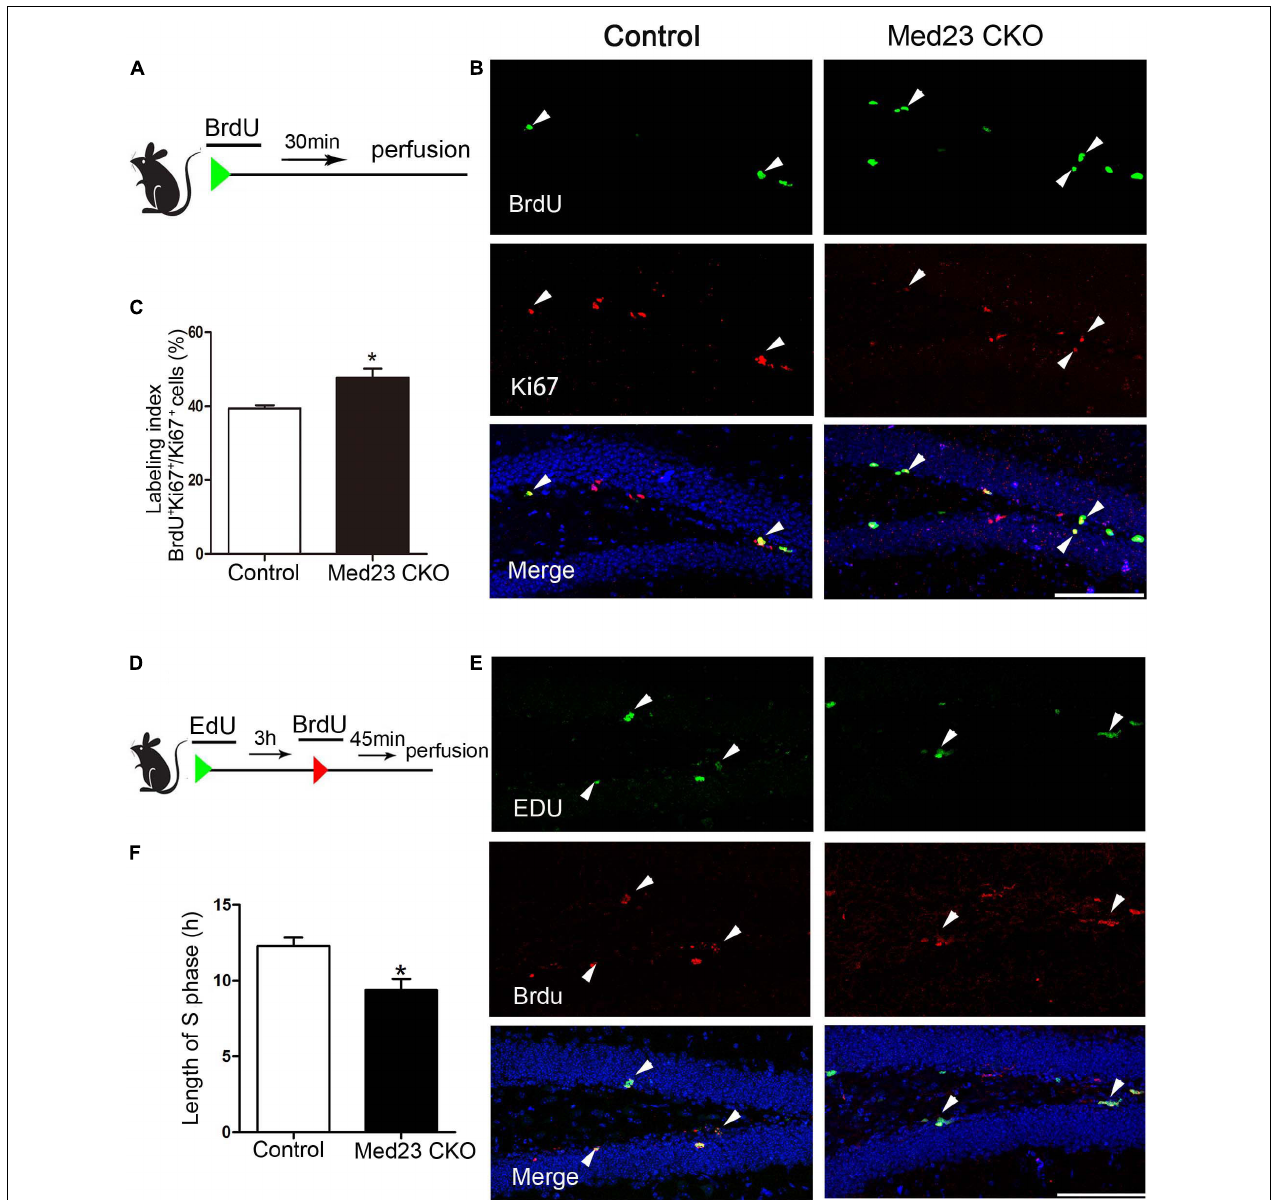
FIGURE 3 | Loss of Med23 affects cell cycle progression of NSCs in the SGZ of adult mice. (A) Schematic representation of BrdU injection. (B) Double immunostaining of BrdU (green) and Ki67 (red) in BrdU-injected mice. Triangles point to BrdU + /Ki67 + cells. Hoechst (blue) was used for counterstaining. Scale bar = 100 µ m. (C) Percentage of BrdU + /Ki67 + cells in the total of Ki67 + cells (labeling index) is significantly increased in Med23 CKO mice compared with controls. N = 5 mice in control and 4 in Med23 CKO groups. (D) Schematic representation of EdU and BrdU injection. (E) Double staining of EdU (green) and BrdU (red) in the SGZ. Triangles point to BrdU + /EdU + cells. Hoechst (blue) was used for counterstaining. Scale bar = 100 µ m. (F) The length of S-phase of NSCs is shorter in Med23 CKO than controls. N = 3 in control and 4 in Med23 CKO groups. Data are plotted as the mean ± SEM. Student t -test, * p < 0.05.